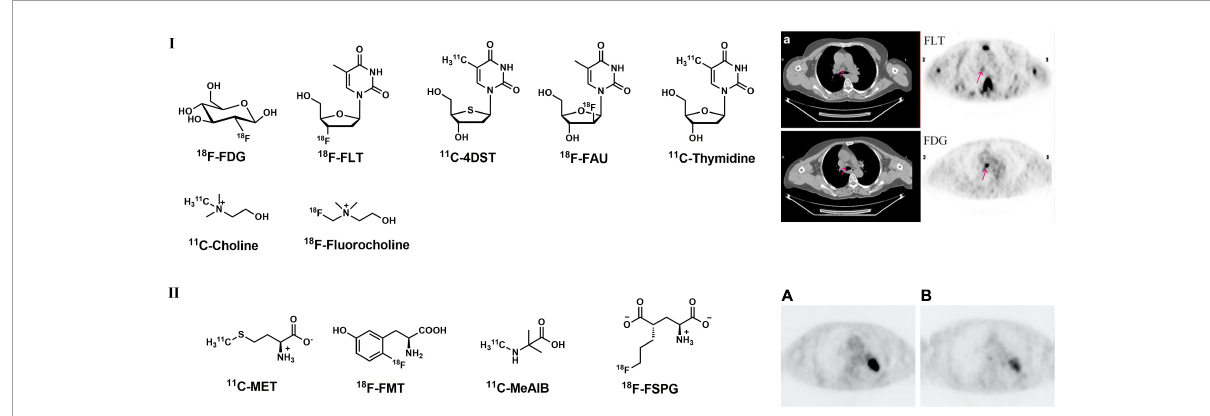
FIGURE1 Structures of representative PET tracers for cellular proliferation, amino acid metabolism and related representative PET images in LC patient. (I) Typical PET and CT images of a 60-year-old patient (female) with adenocarcinoma with 18 F-FLT (upper) and 18 F-FDG (lower) ; (II) 18 F-FDG (A) and 18 F-FMT (B) images in 74-year-old patient (male) with lung adenocarcinoma.